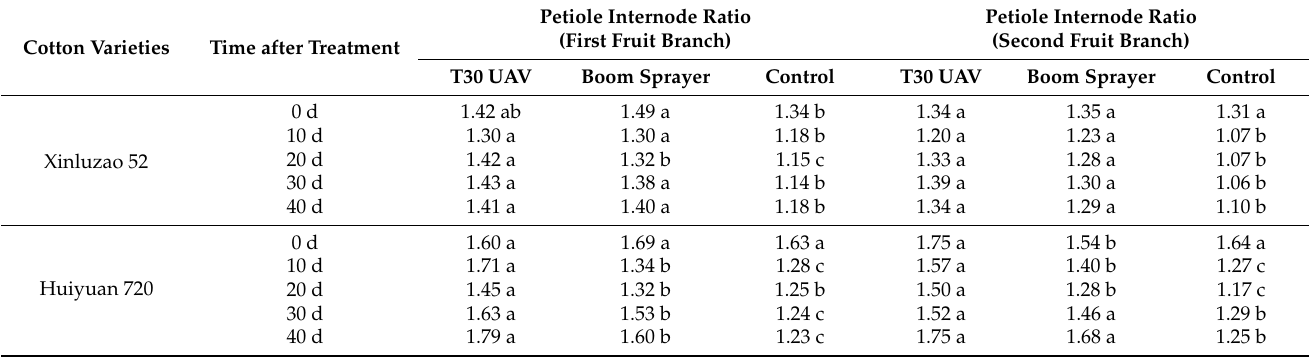
Petiole Internode Ratio (Second Fruit Branch)